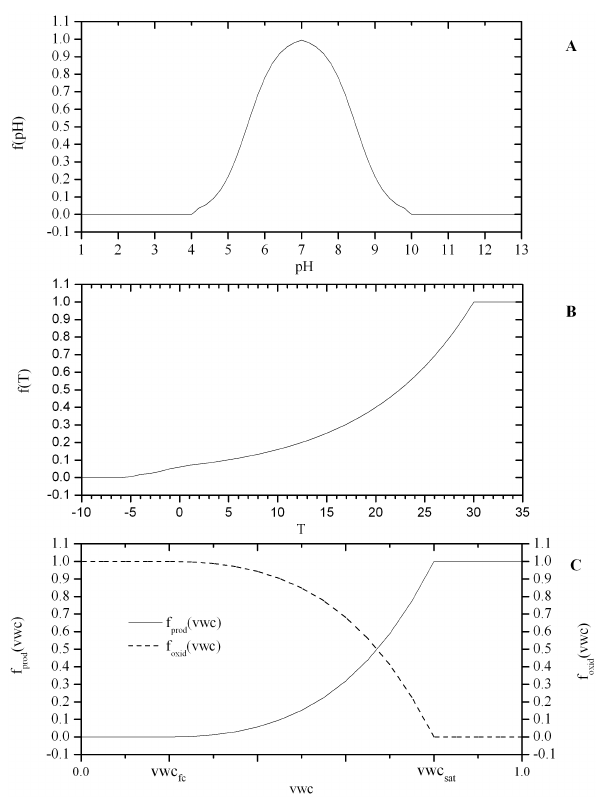
Fig. 3. Graphs showing environmental effects on methane pro- duction and oxidation – (A) pH effects; (B) Temperature effect; (C) Moisture effects on methane production and